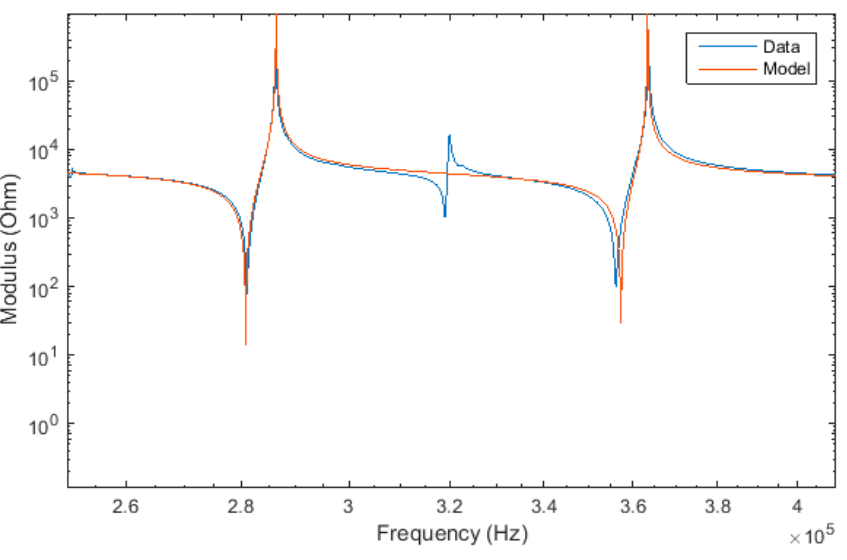
Figure 4. Impedance modulus spectrum of Y-cut LiNbO 3 around the radial resonance.